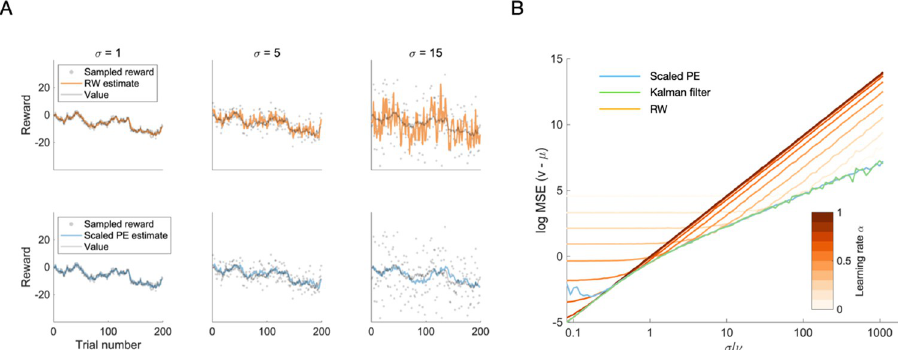
Fig 2. Reward prediction performance of the RW, SPE and Kalman filter models. A The first 200 trials of reward prediction for the RW learner (upper row, orange color) and the SPE learner (lower row, blue color). The true value (grey line), the observed rewards (grey dots) and the learner’s estimate (colored line) are shown as a function of trial number. Columns correspond to selected levels of observation noise ( σ = 1, 5, 15). B Learning performance averaged over trials. We show the logarithm of the mean squared difference between the mean of the reward distribution and the learner’s prediction thereof, as a function of the observation noise σ . Orange lines correspond to RW learners, the = 1 and α = 0.01, and the green line corresponds to a blue line corresponds to a SPE learner parametrized with α m s Kalman filter parametrized with the true underlying process and observation noise parameters. The different shades of orange correspond to different learning rates, as indicated by the color